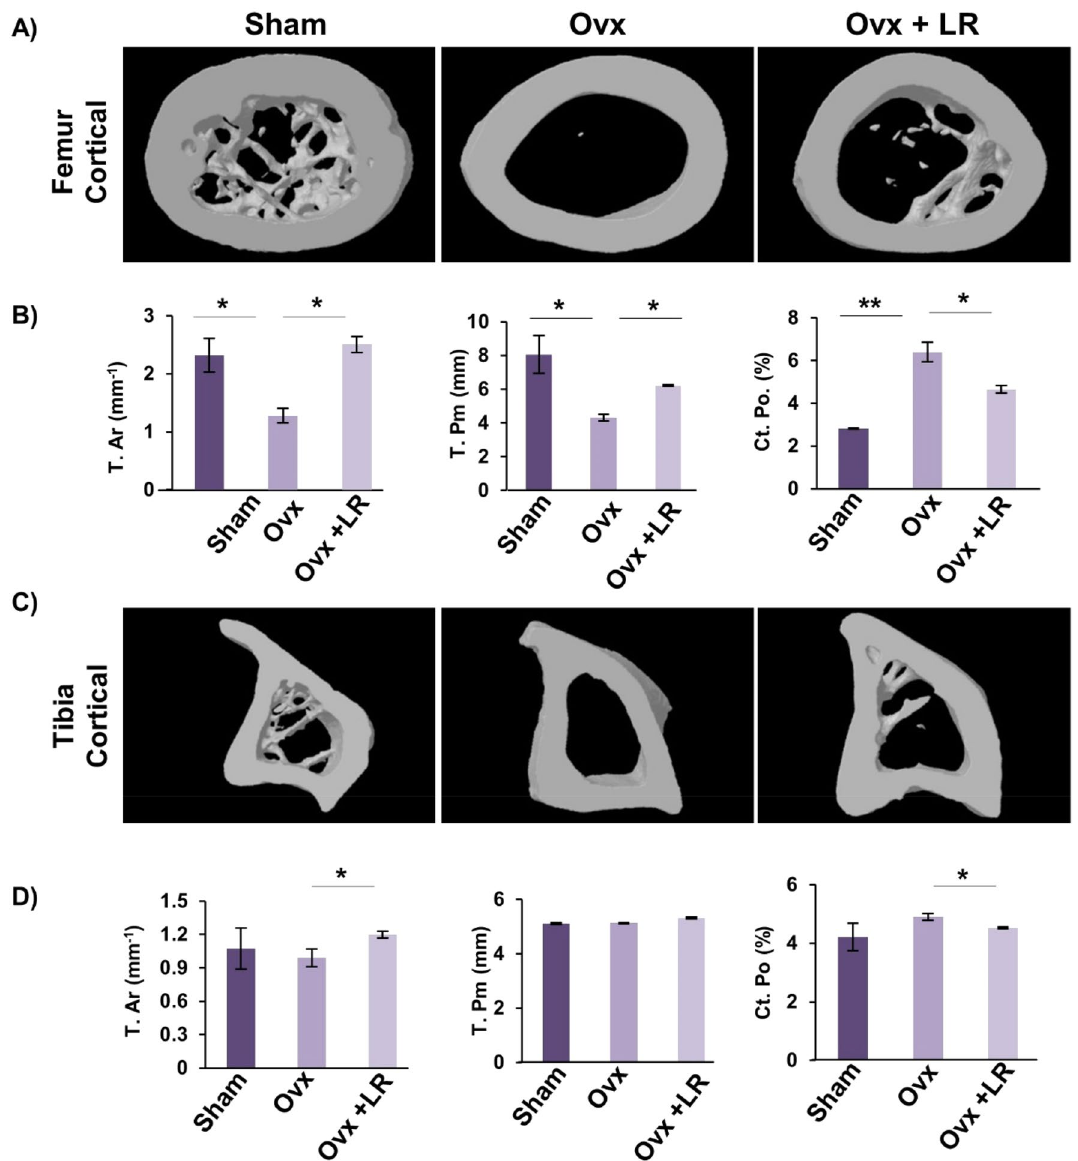
Figure 6. LR administration enhances cortical bone microarchitecture. 3-D u-CT reconstruction of Femur Cortical and Tibia Cortical of all groups. ( A ) Bone micro-architecture of Femur Cortical. ( B ) Histomorphometric parameters of Femur Cortical. ( C ) Bone micro-architecture of Tibia Cortical. ( D ) Histomorphometric parameters of Tibia Cortical. T. Ar., bone tissue area; T. Pm., total cross-sectional perimeter; Ct. Po., cortical porosity. The results were evaluated by ANOVA with subsequent comparisons by Student t-test for paired or nonpaired data. Values are reported as mean ± SEM. The above graphical representations are indicative of one independent experiment and similar results were obtained in two different independent experiments with n = 6. Statistical significance was considered as p ≤ 0.05 (* p ≤ 0.05, ** p ≤ 0.01, *** p ≤ 0.001) with respect to indicated mice